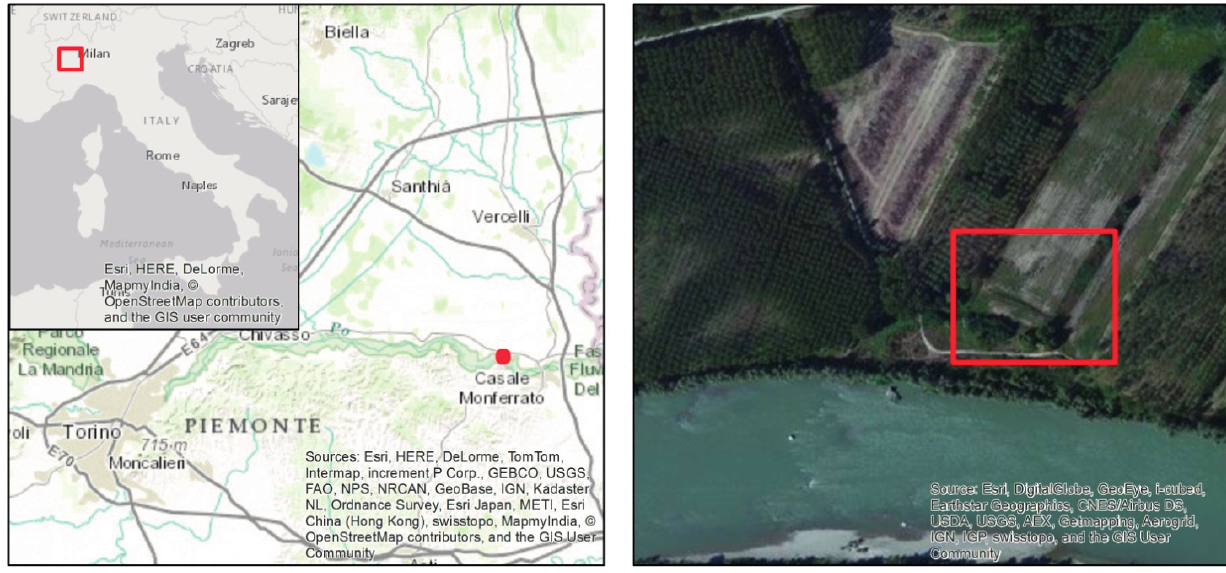
Figure 1. Deployment exercise location ( left ) and detail of the area to be mapped ( right